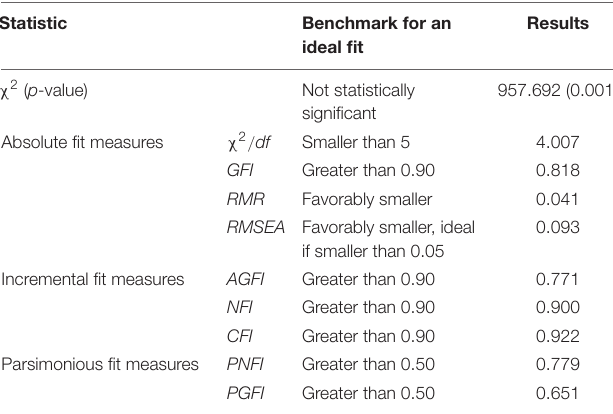
TABLE 5 | Goodness-of-fit indices of the conceptual framework model developed in this study.